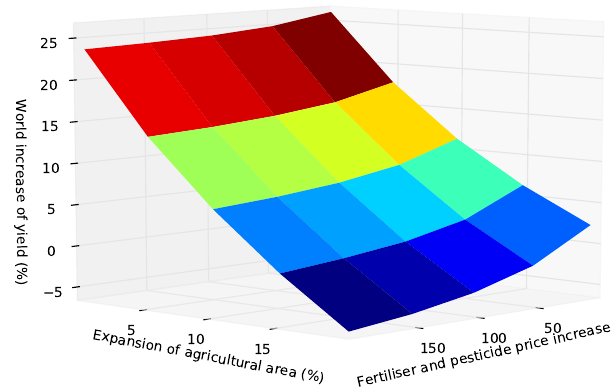
Fig. 14. Variations of crop yields in function of chemical inputs price and expansion rate of agricultural lands 2001 and 2050.